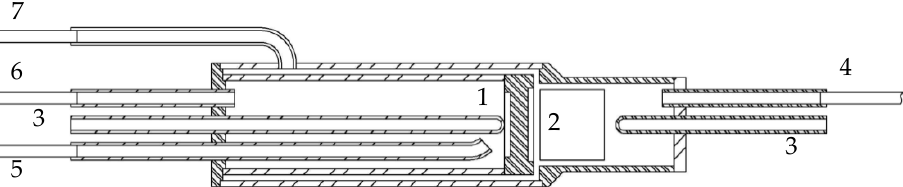
Figure 2. Scheme of catalytic reactor for ethanol steam reforming: 1—asymmetric supported hydrogen separation membrane, 2—honeycomb catalyst, 3—thermocouples pockets, 4—tube for feed gas mixture feeding, 5—purge (sweep) gas feeding tube, 6—permeate outlet tube, 7—bypass tube.